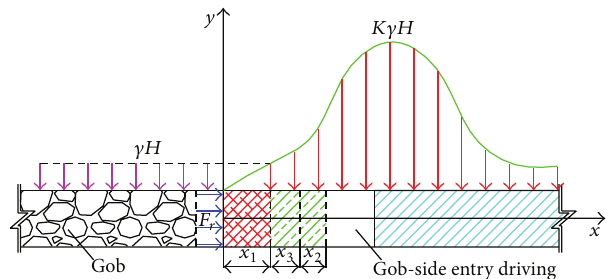
Figure 14: Diagram for the calculation of the reasonable width of the narrow coal